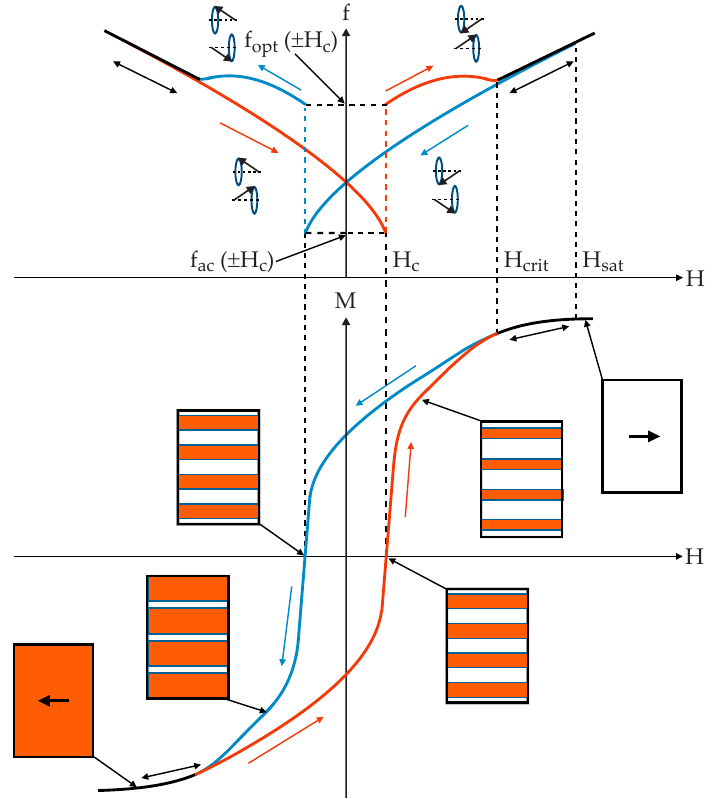
Figure 9. Schematic illustrations of the in-plane magnetization and in-plane FMR hysteresis loops. In the lower panel, for the M – H loop, we indicate the stripe domain patterns, which schematically show the relative sizes of the oppositely aligned magnetic stripe domain structure. The reversible portions (black), as well as the up-sweep (red) and down-sweep (blue) branches of the magnetization reversal loop, are also shown. The corresponding color scheme is also used in the upper panel for the FMR hysteresis. Indicatively shown are the expected acoustic and optical